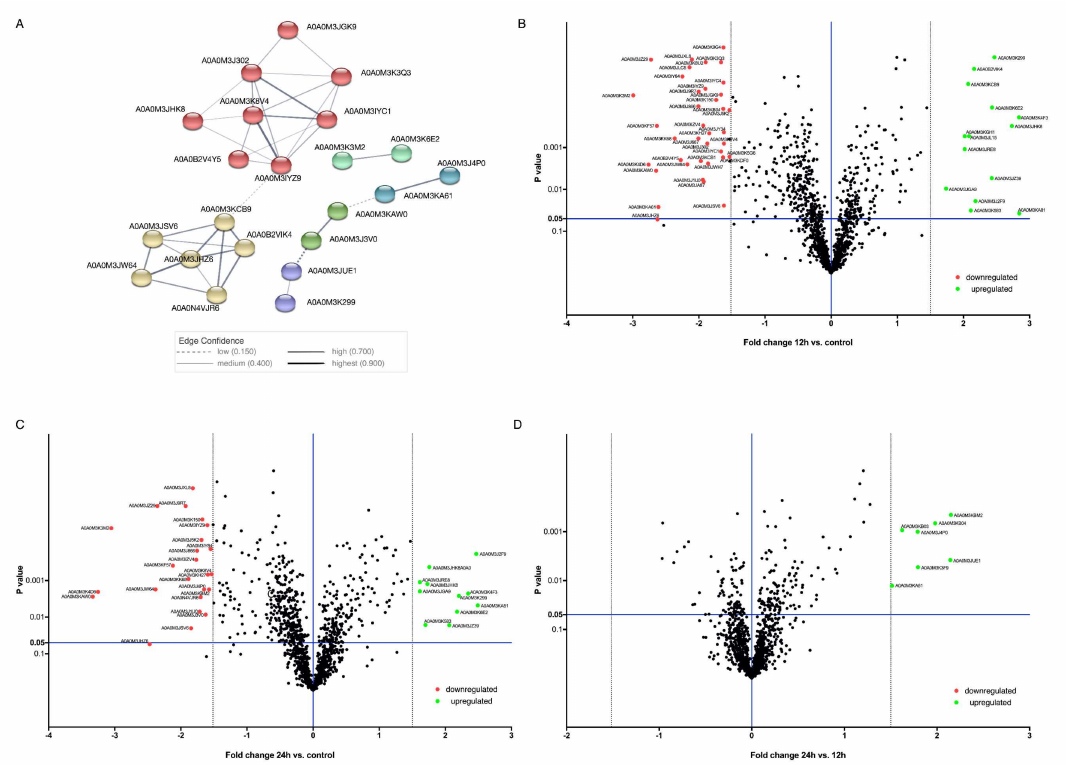
Figure 2. Graphical representation of obtained data. ( A ) Protein–protein interaction network analysis of di ff erentially regulated proteins after ivermectin treatment of L3 larvae of Anisakis simplex s.s. Volcano-plot representations of the statistical analysis of ivermectin-treated L3 larvae of Anisakis simplex s.s.: ( B ) control vs. 12 h of treatment, ( C ) control vs. 24 h of treatment, and ( D ) 24 h of treatment vs. 12 h of treatment. To see the legend for protein IDs, see Supplementary File